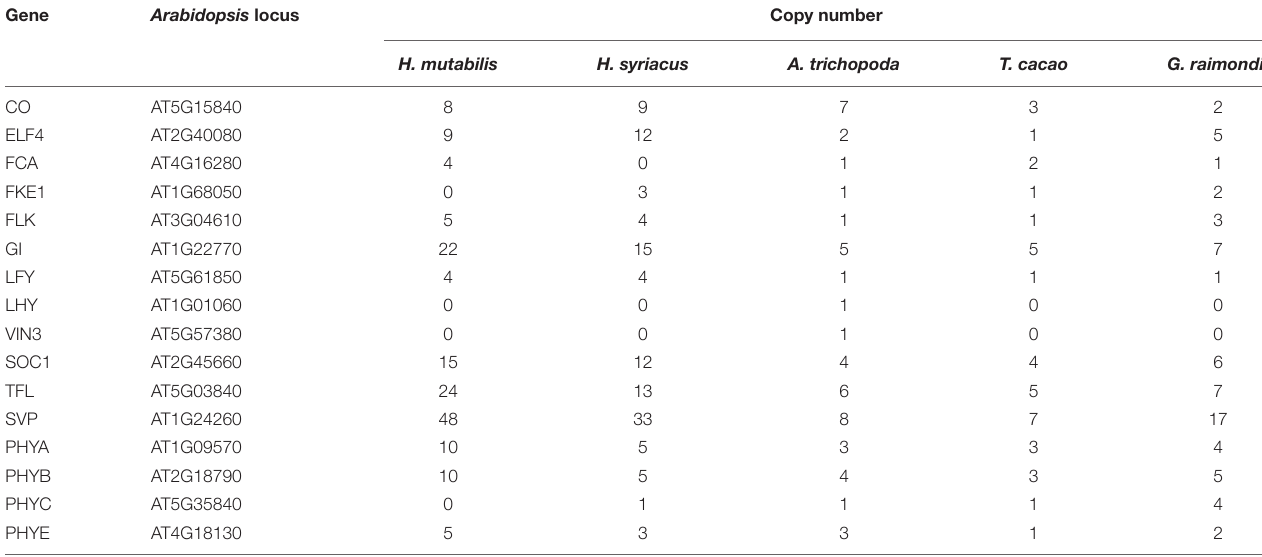
TABLE 1 | Copy numbers of genes encoding flowering time regulators in five plant species.